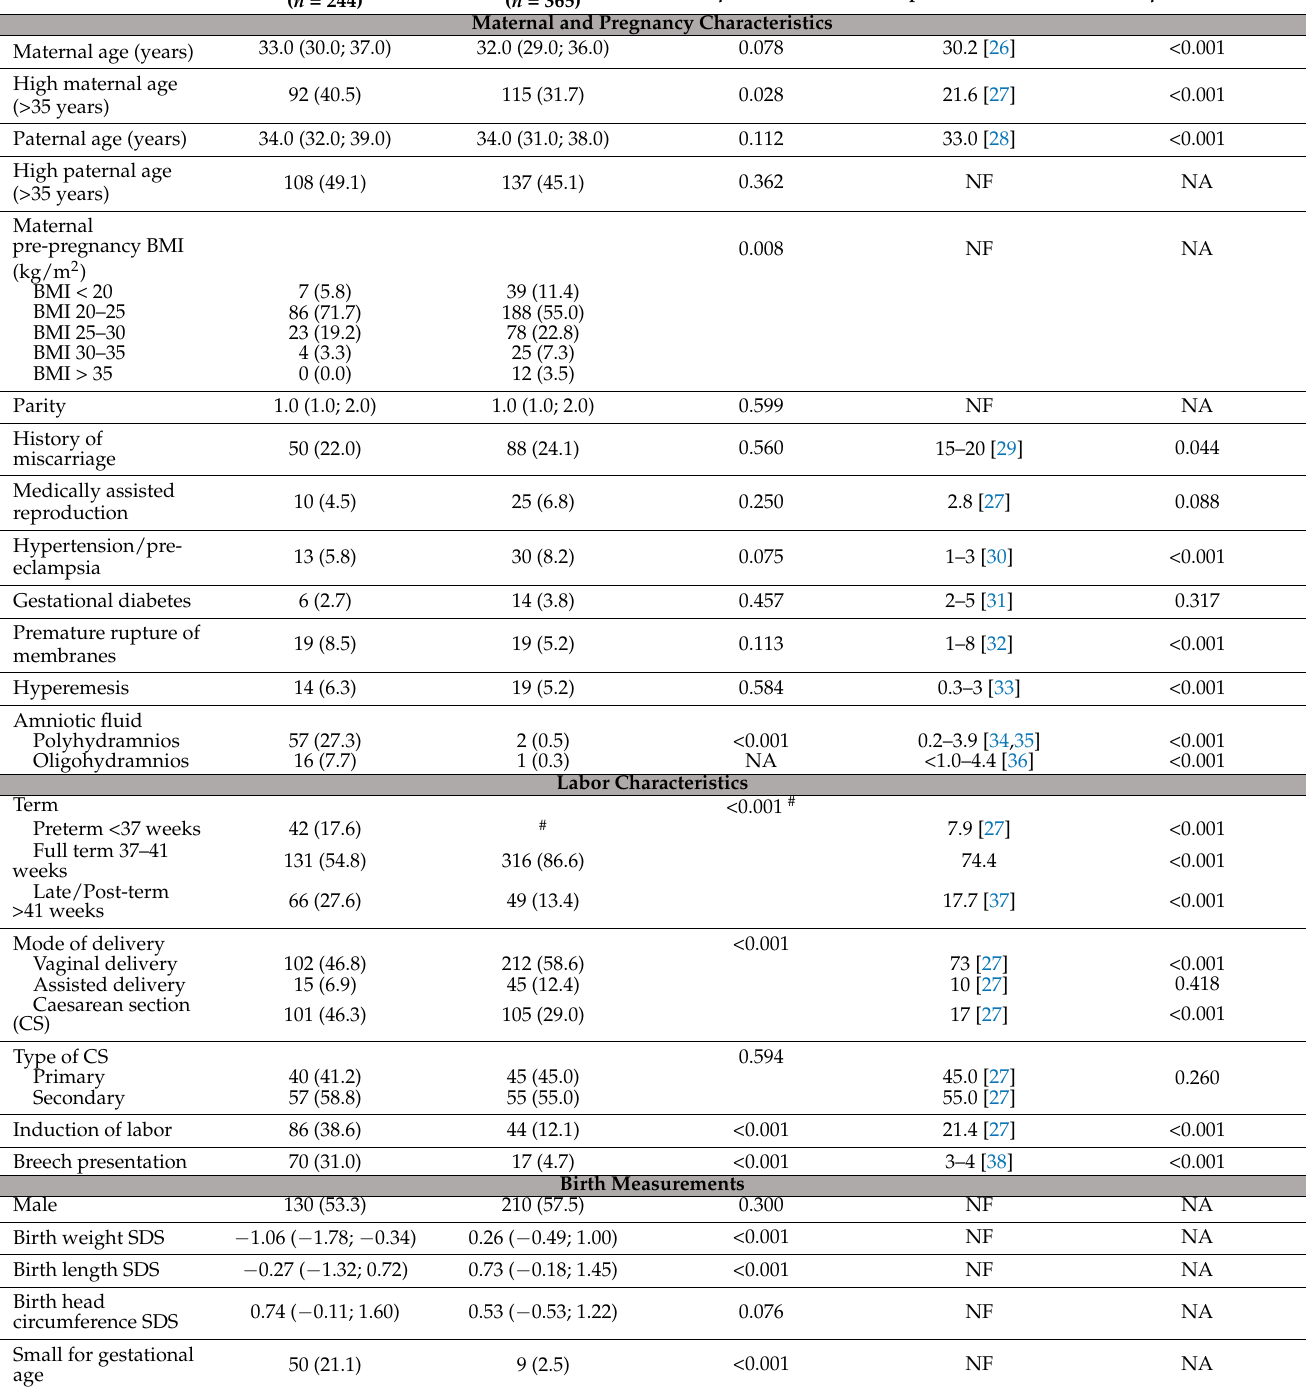
Table 1. Characteristics of the PWS cohort compared to the PLUTO cohort and population statistics. PWS Cohort PLUTO Cohort p -Value * Population Statistics p -Value ** ( n = 244) ( n = 365) Maternal and Pregnancy